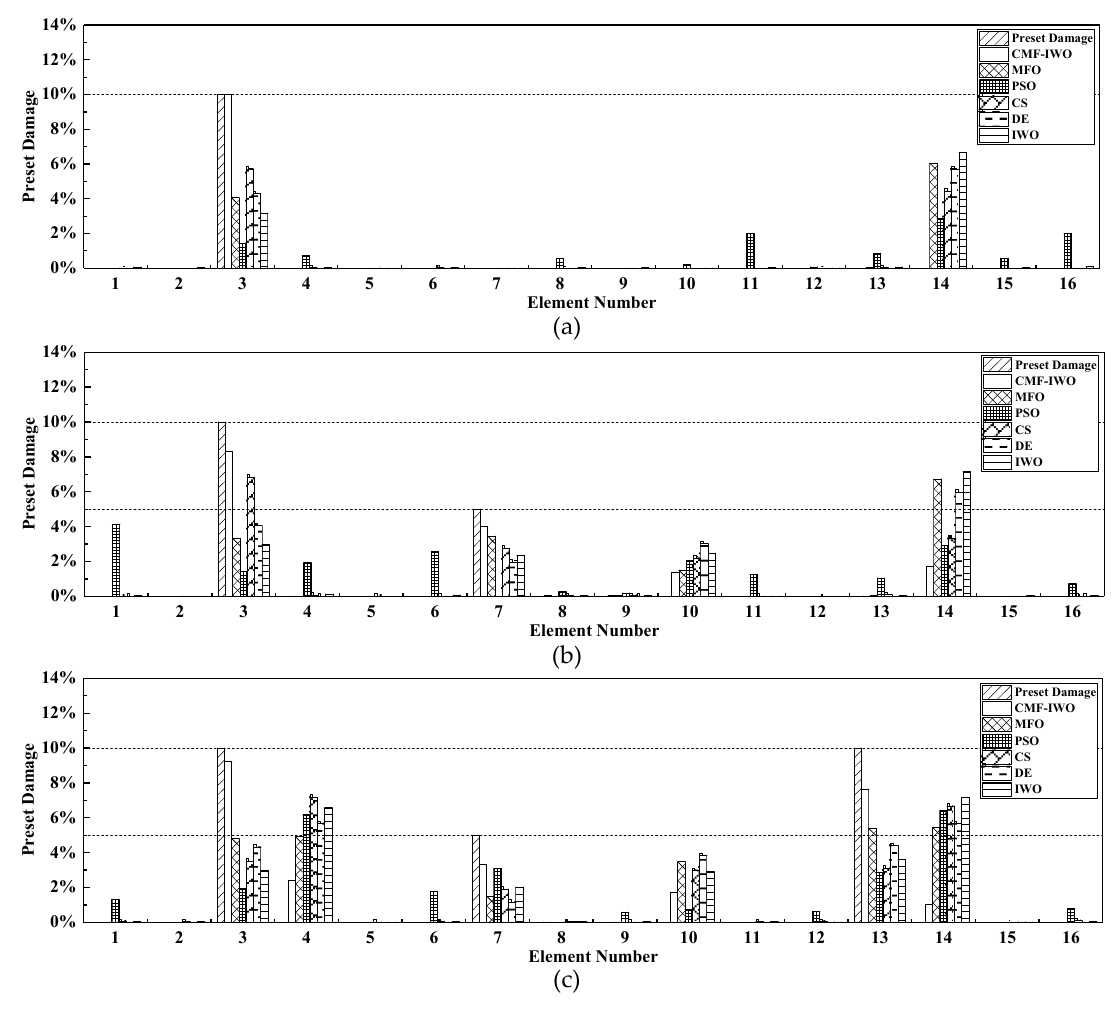
Figure 4. Damage identification results of simply supported beam: ( a ) Case 1; ( b ) Case 2, and ( c ) Case 3.